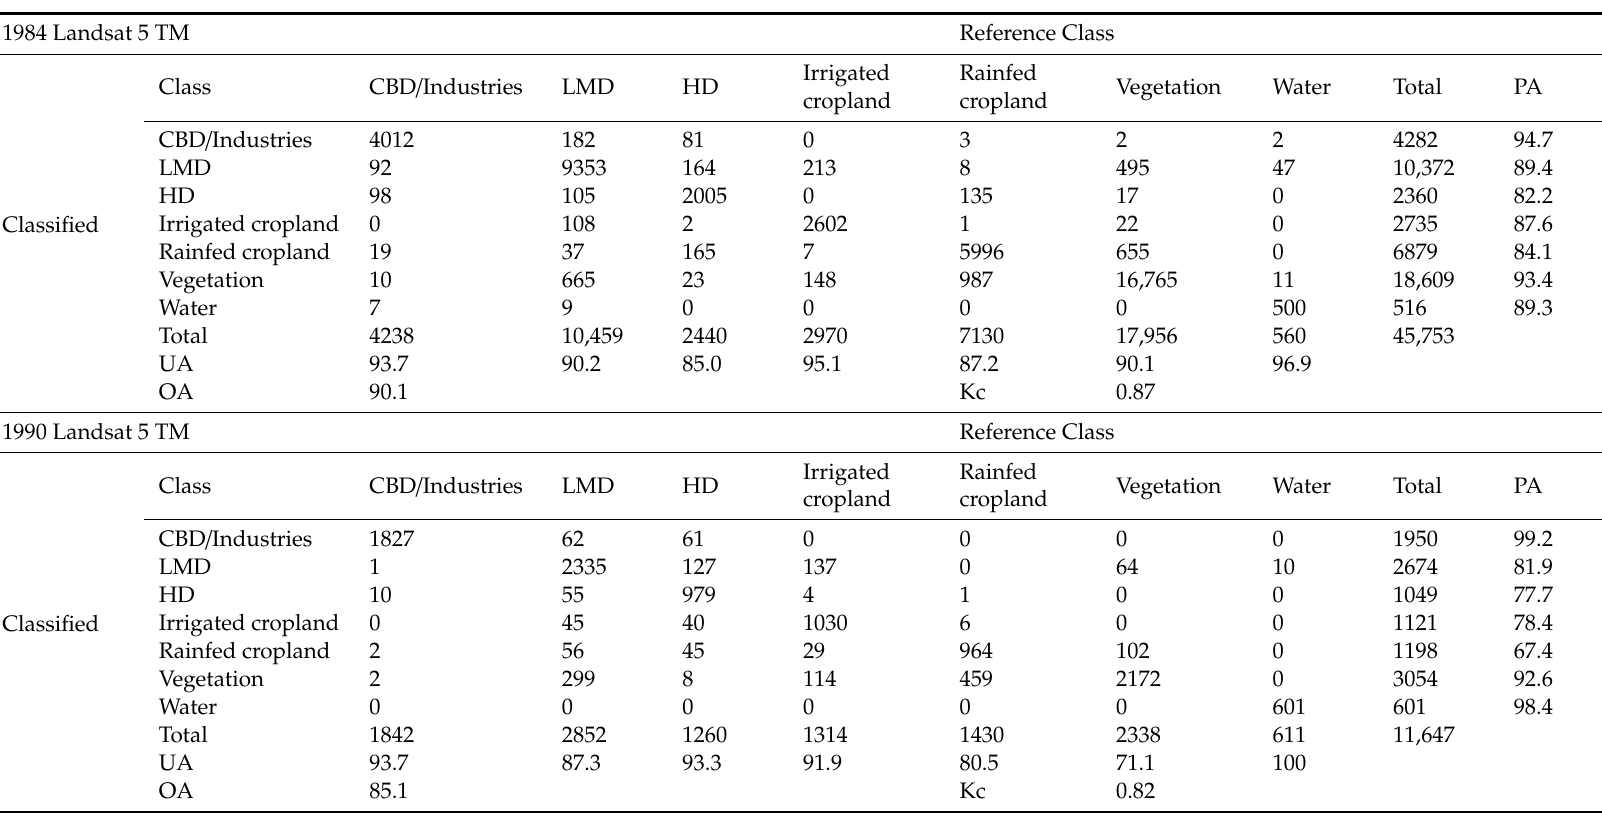
Table A1. Confusion matrix and associated classification accuracies produced from Landsat 5 TM (1984, 1990, 2000 and 2008). These include kappa coe ffi cient (Kc), overall accuracy (OA), producer’s accuracy (PA) and user’s accuracy